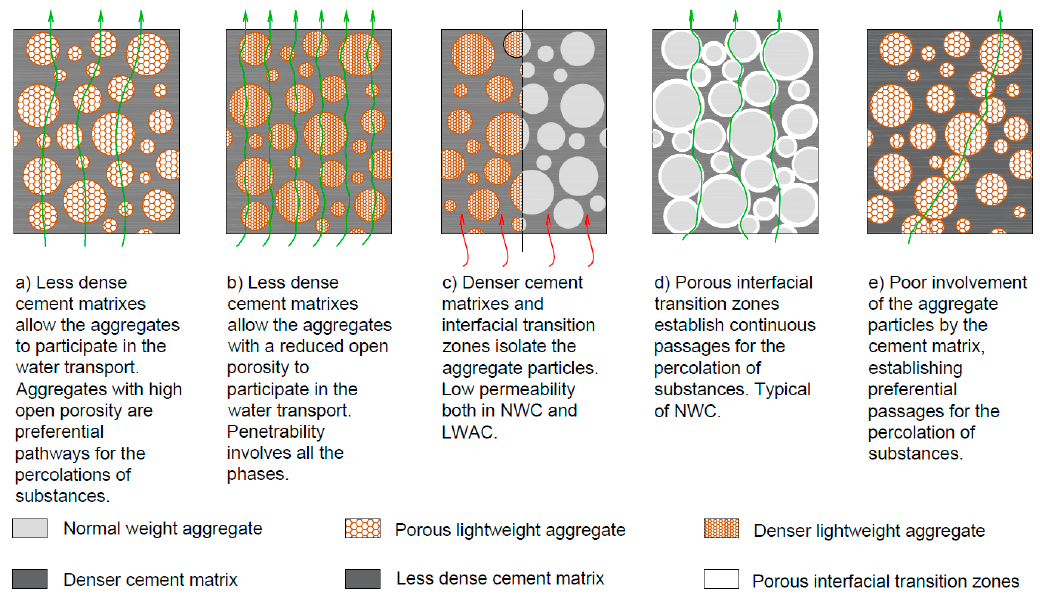
Figure 2. Schematic representation of penetrability of different types of concrete (adapted from [2,25]) .